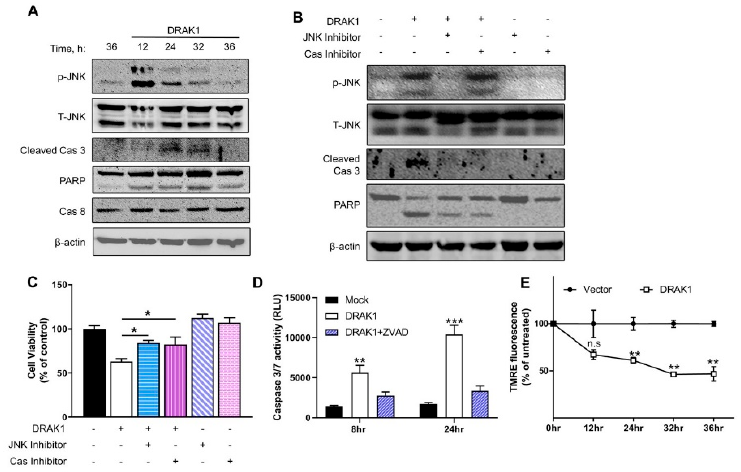
Figure 3. DRAK1 overexpression activates JNK signaling and caspase 3 cleavage to promote apoptosis. ( A ) PC3 cells were transfected with DRAK1 and cell lysates from the indicated time points immunoblotted with indicated antibodies. PC3 cells were treated with JNK inhibitor (SP600125, 25 µ M) or caspase 3 inhibitor (zVAD-FMK, 20 µ M) and transfected with DRAK1 for 24 h and ( B ) Cell lysates were probed with indicated antibodies and normalized to β -actin levels, ( C ) Cell viability analyzed by MTT assay. ( D ) PC3 cells were transfected with vector alone or DRAK1 in the presence or absence of caspase 3 inhibitor (zVAD-FMK, 20 µ M). Caspase 3 / 7 activity was measured in cell lysates after 24 h. ( E ) Cells expressing DRAK1 or vector alone were stained with TMRE at indicated times and fluorescence intensity was normalized to control cells. Values shown are mean ± s.d of triplicate assays. * p < 0.01, ** p < 0.001, *** p < 0.0001, n.s: not